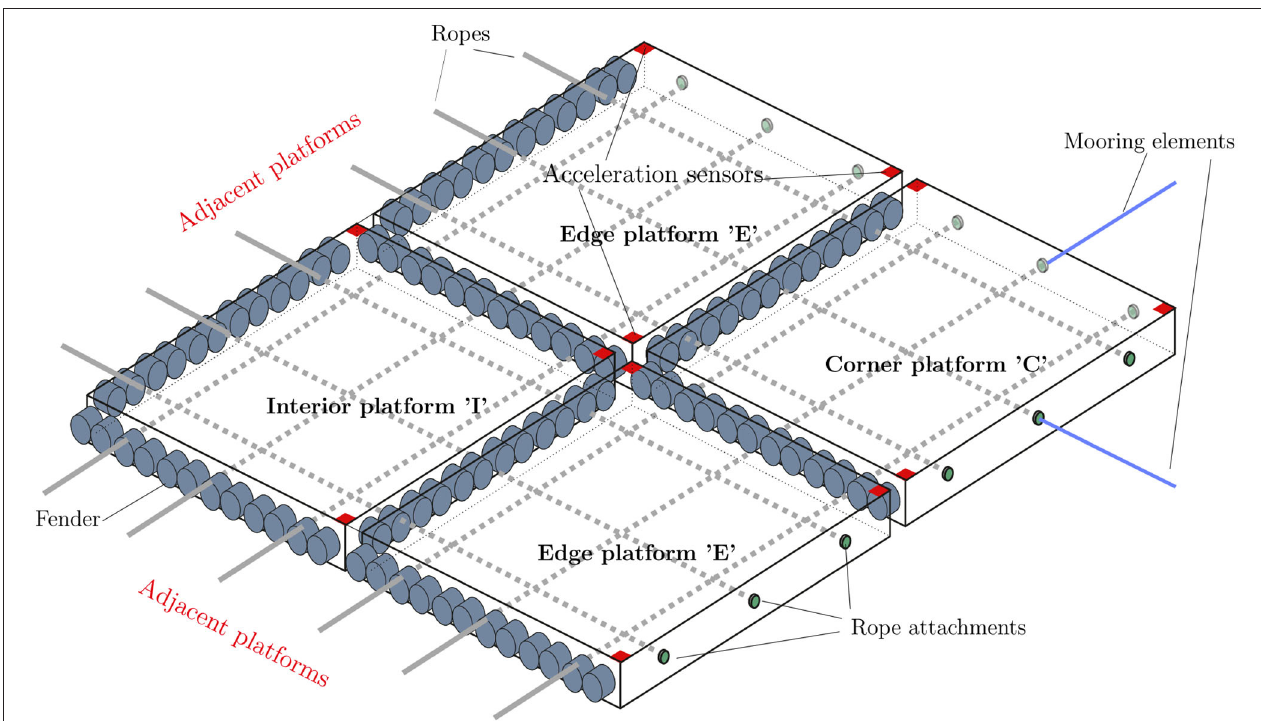
FIGURE 2 | Arrangement of the synthetic fiber ropes, elastomer fenders, and mooring lines on four platform elements placed on the corner of a platform array with three acceleration sensors per platform.